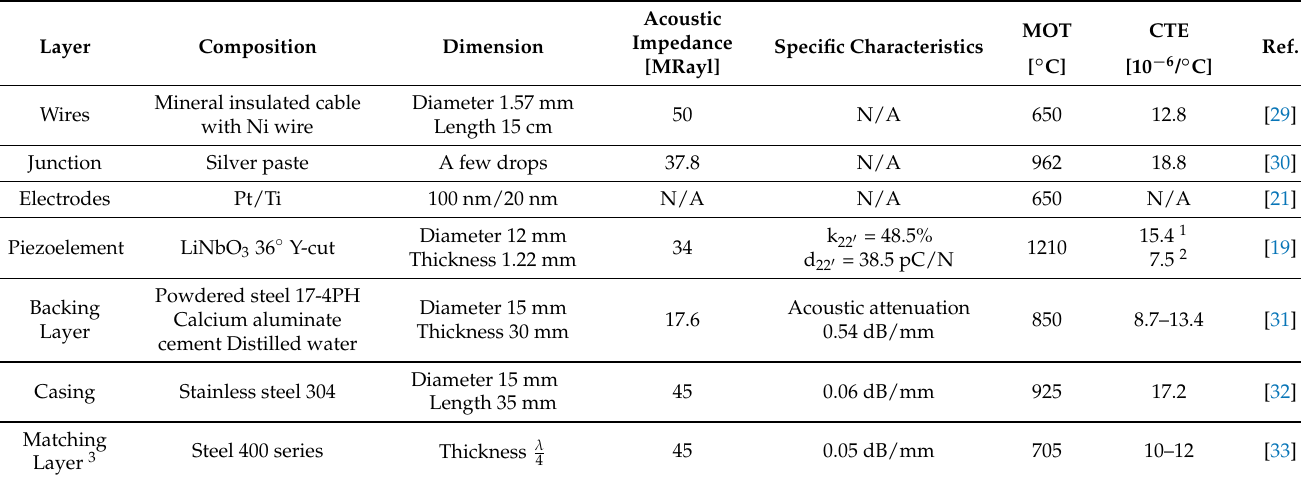
Table 1. Composition and properties of the selected materials.